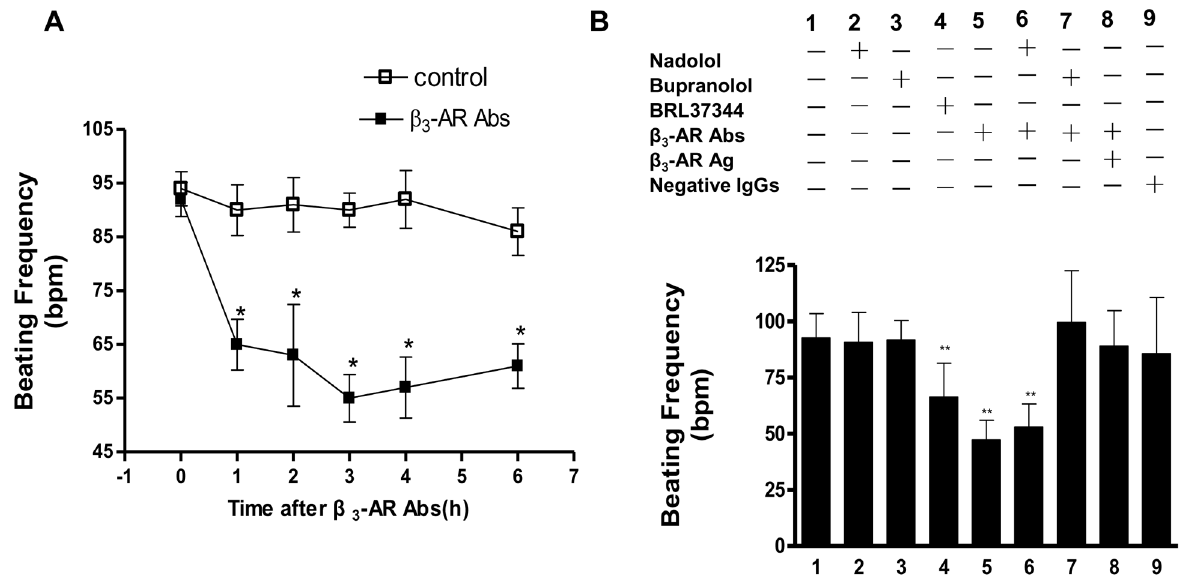
-AR Abs in cultured neonatal rat cardiomyocytes. A. Negative chronotropic Figure 5. Negative chronotropic effects of β 3 effects of β -AR Abs (0.1 µmol/L) upon beating frequency of neonatal rat cardiomyocytes at different time points. * P < 0.05, ** P < 3 0.01. B. Negative chronotropic actions of β -AR Abs (0.1 µmol/L) on beating frequency of neonatal rat cardiomyocytes after one 3 hour exposure. The effects of nadolol, bupranolol, and β -AR antigen peptide on the actions of β 3 control. (n=10). doi: